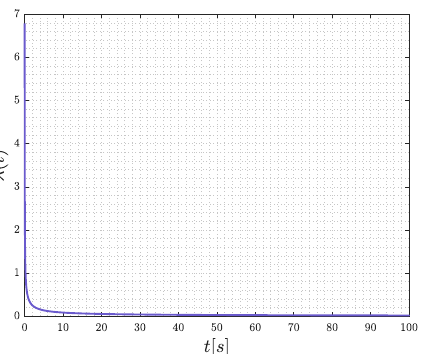
Figure 1. Function x ( t ) vs. time t .